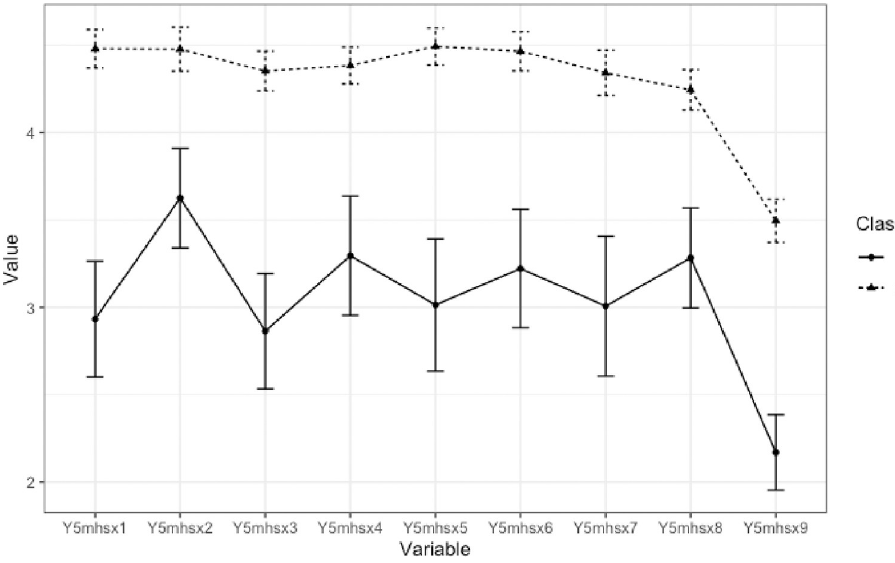
Fig 1. Means across profiles of the 2-class latent profile analysis. Items correspond to the order of items in the mental well-being scale in the methods